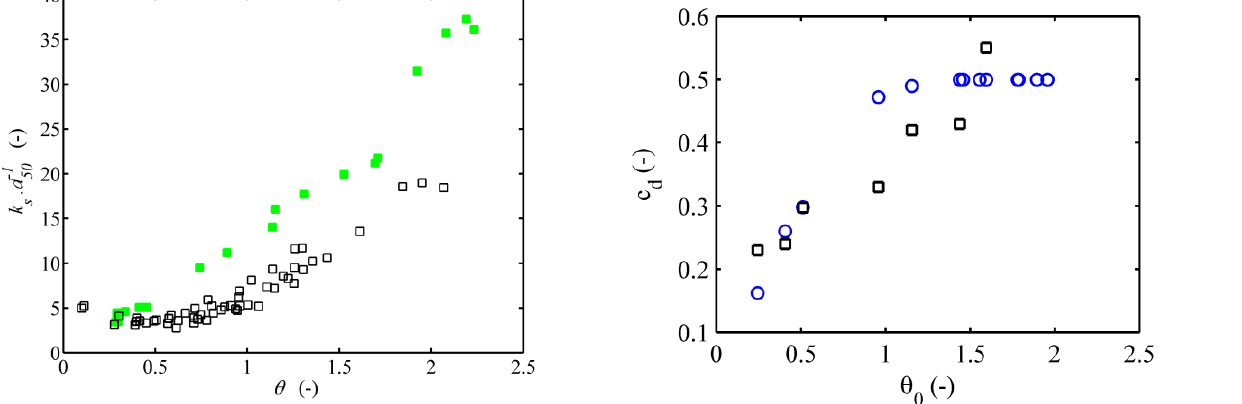
Fig. 9. Dimensionless bed roughness versus dimensionless bed shear stress, Legend: empty square – TLT50, full square – FA60.